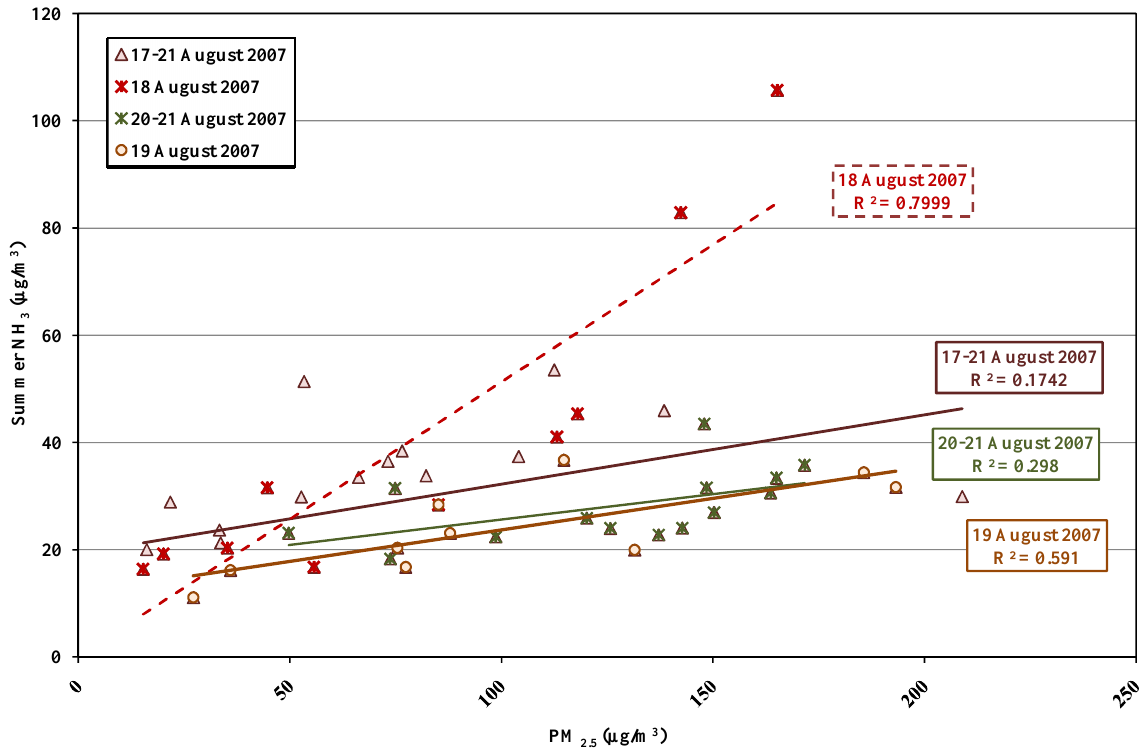
Fig. 9. Relationship between NH 3 and PM 2 . 5 during the intensive summer